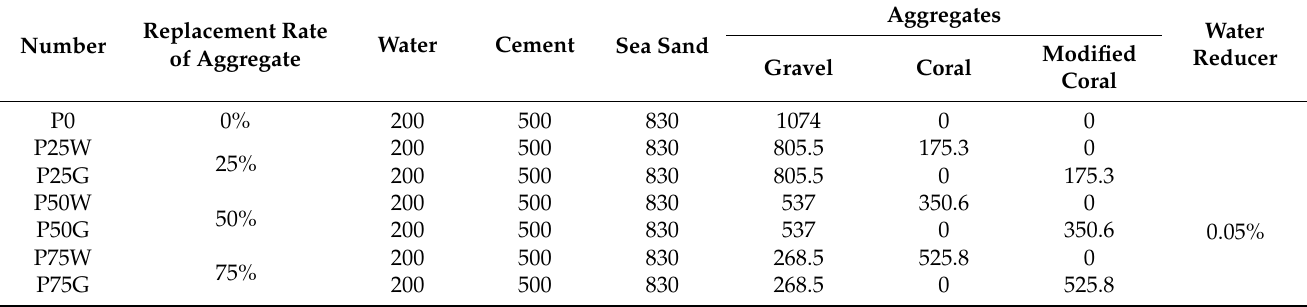
Table 6. Mix design of concrete (kg/m 3